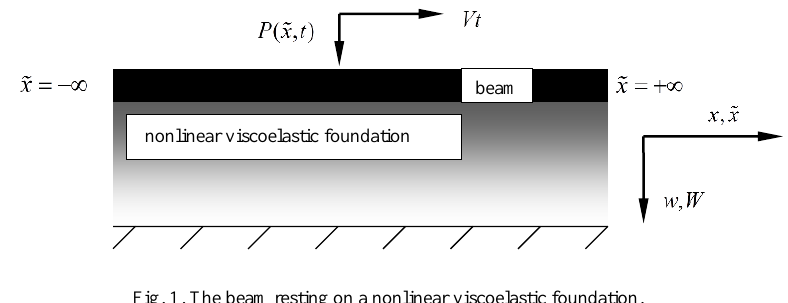
Fig. 1. The beam resting on a nonlinear viscoelastic